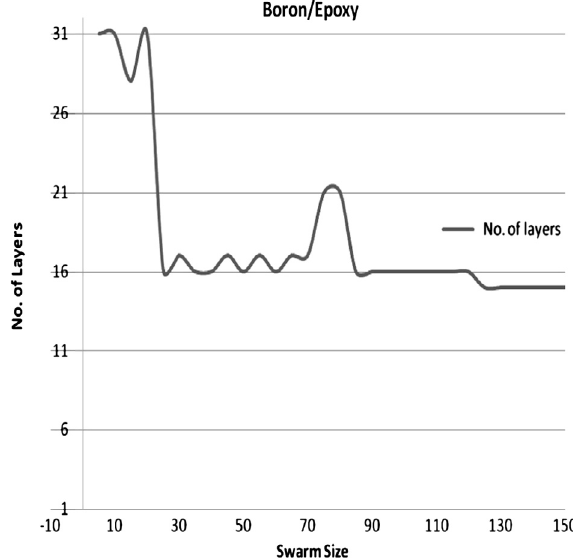
Figure 10. Variations of number of layers of Boron/Epoxy drive shafts with swarm